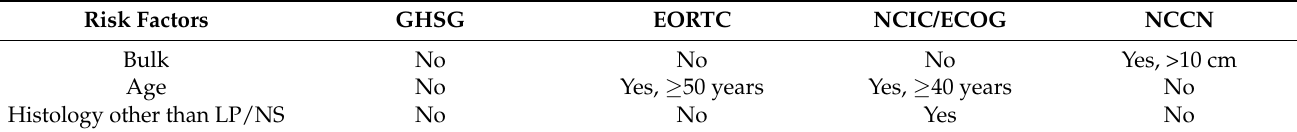
Abbreviations: CS clinical stage, ESR erythrocyte sedimentation rate, A without B-symptoms, B with B-symptoms, LP lymphocyte predominant, NS nodular sclerosis, GHSG German Hodgkin Study Group, EORTC European Organization for Research and Treatment of Cancer, NCIC National Cancer. Institute of Canada, ECOG Eastern Cooperative Oncology Group, NCCN National Comprehensive Cancer Network. 1 According to GHSG, patients with CSIIB and a large medias- tinal mass or extranodal disease are considered as advanced stage.